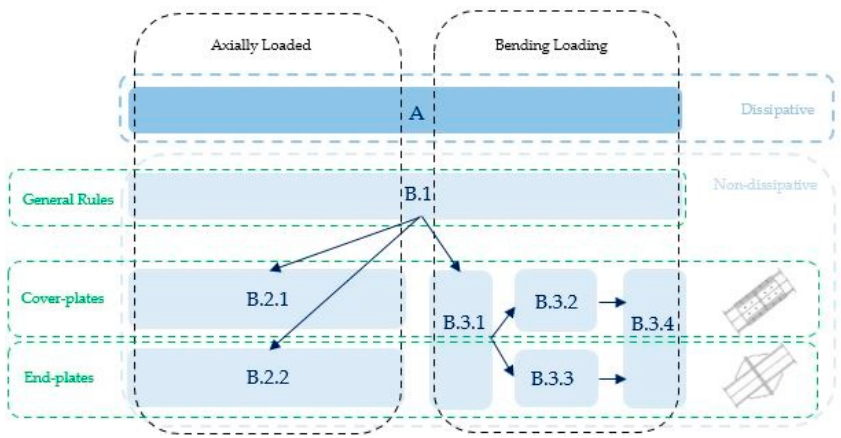
Figure 7. Steps of practical seismic design of bolted steel connections according to Eurocodes.